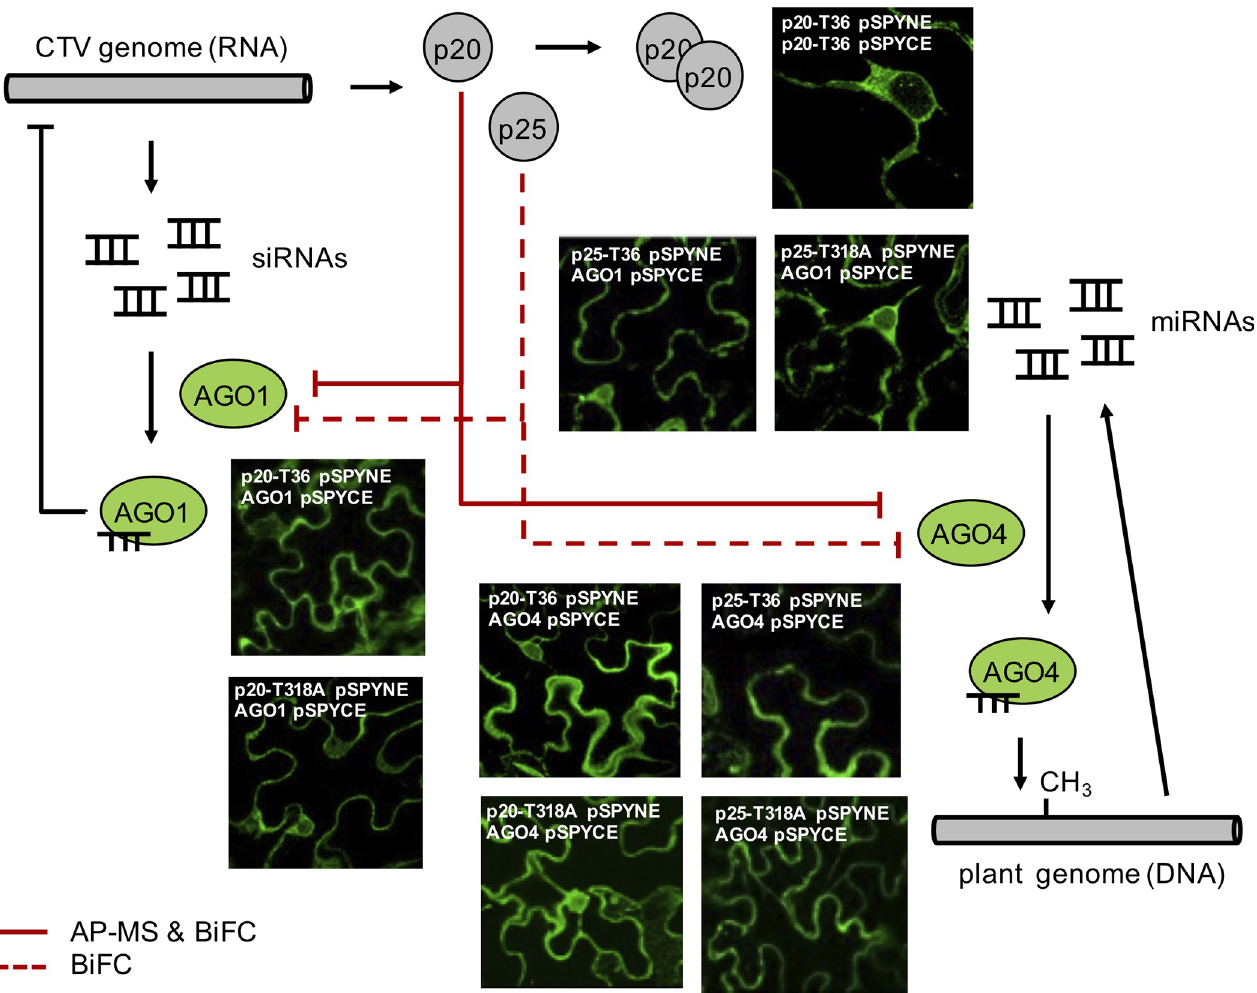
Fig 5. Schematic representation of the regulatory circuit established between p20 and p25 (from the virus) and AGO1 and AGO4 (from the plant) in which patterns of degeneracy are manifested, together with images of BiFC assays in planta by using a split YFP system to prove the virus-host protein- protein